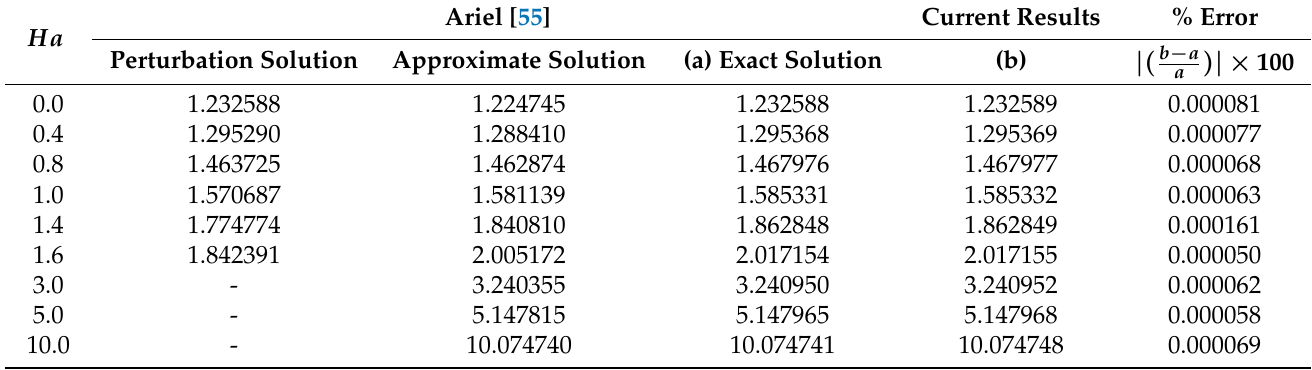
Table 2. Comparison of f (cid:48)(cid:48) ( 0 ) obtained by FEM and that of Ariel [55] for β = 1 and when all other parameters are fixed zero. Ha